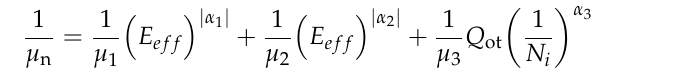
Figure 8. The equivalent circuits of transient pulse propagation corresponding to the ( a ) “ 0 → 1 ” upset type and ( b ) “ 1 → 0 ” upset type in the 7T SRAM.